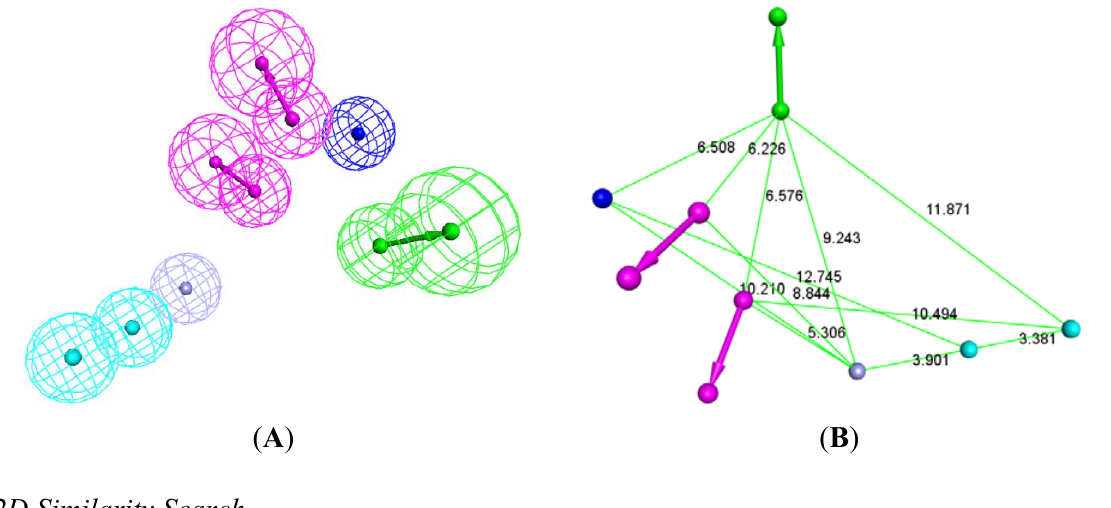
Figure 6. Structure-based pharmacophore of the active site of Glo-1 enzyme. ( A ) 3D representation of this pharmacophore; HY: sky-blue; NI: blue; HBD: magenta; HBA: green; ZB: purple. ( B ) simplified structure-based pharmacophore with no tolerance spheres to facilitate visualization of inter feature distances; HY: sky-blue; NI: blue; HBD: purple; HBA: green; ZB: